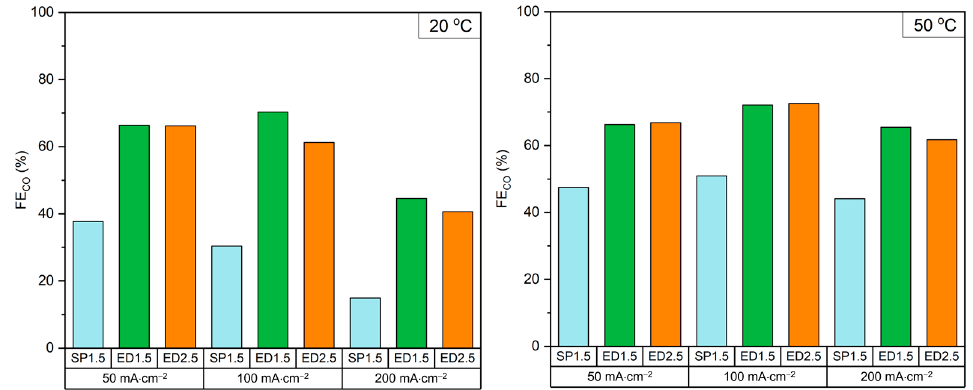
Figure 2. FE CO of the three Ag cathodes tested at 20 °C and 50 °C.